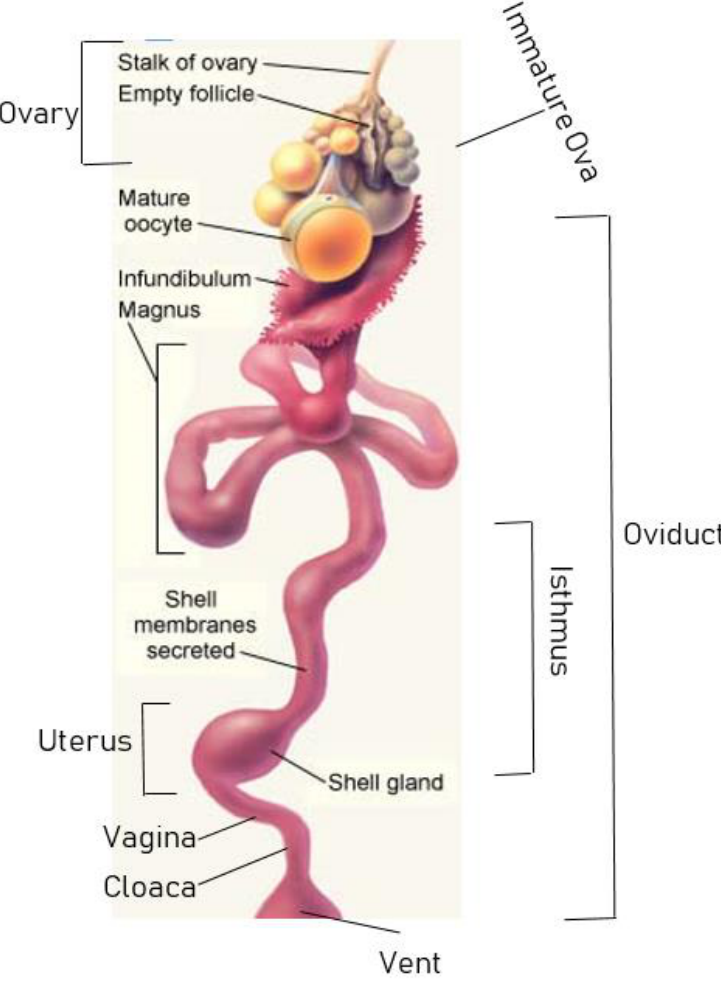
Figure 1. Schematic diagram detailing the process of egg formation.